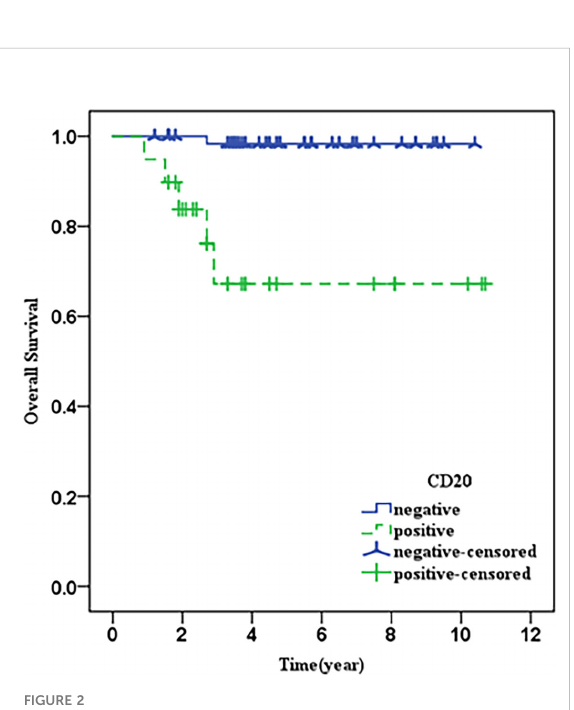
FIGURE 3 The overall survival of patients with different status of EBV infection and CD20